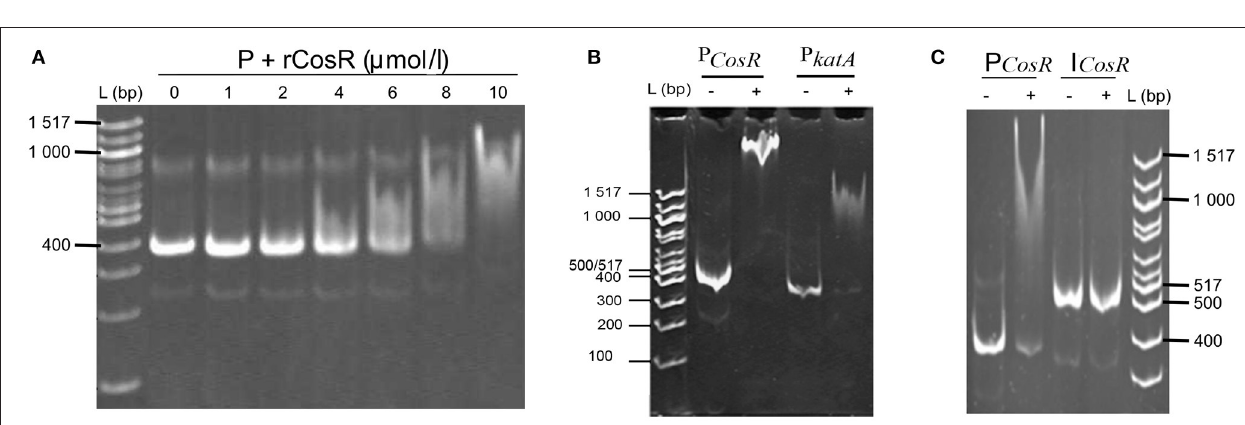
FIGURE 5 | In vitro interactions of rCosR with promoter regions. (A) Titration of a 374-bp cosR promoter DNA with rCosR. (B) Shift mobility of 374-bp cosR promoter DNA of C. jejuni 81–176 and the positive control using a 337-bp katA promoter DNA of C. jejuni NTCTC 11168 performed with 10 µ mol/l rCosR. (C) Mobility of the promoter and internal DNA fragments of cosR with ( + ) or without ( − ) the addition of 10 µ mol/l of the purified r CosR protein. L corresponds to 100 bp molecular weight ladder (NE